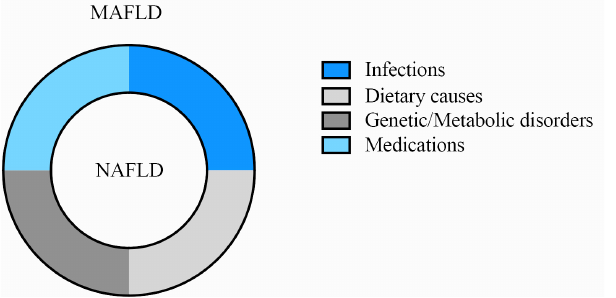
Figure 4. The relationship between MAFLD and NAFLD (wheel model). The inner circle represents nonalcoholic fa tt y liver disease (NAFLD), and the outer circle represents metabolic-associated fa tt y liver disease (MAFLD). The four colors indicate infections, dietary causes, medications and ge- netic/metabolic disorders.